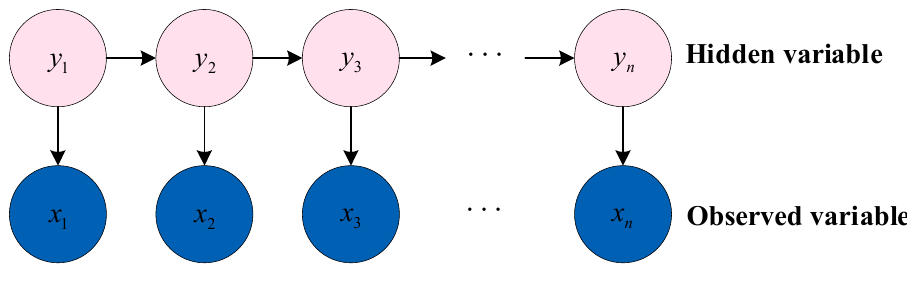
Figure 13. Structure of HMM.